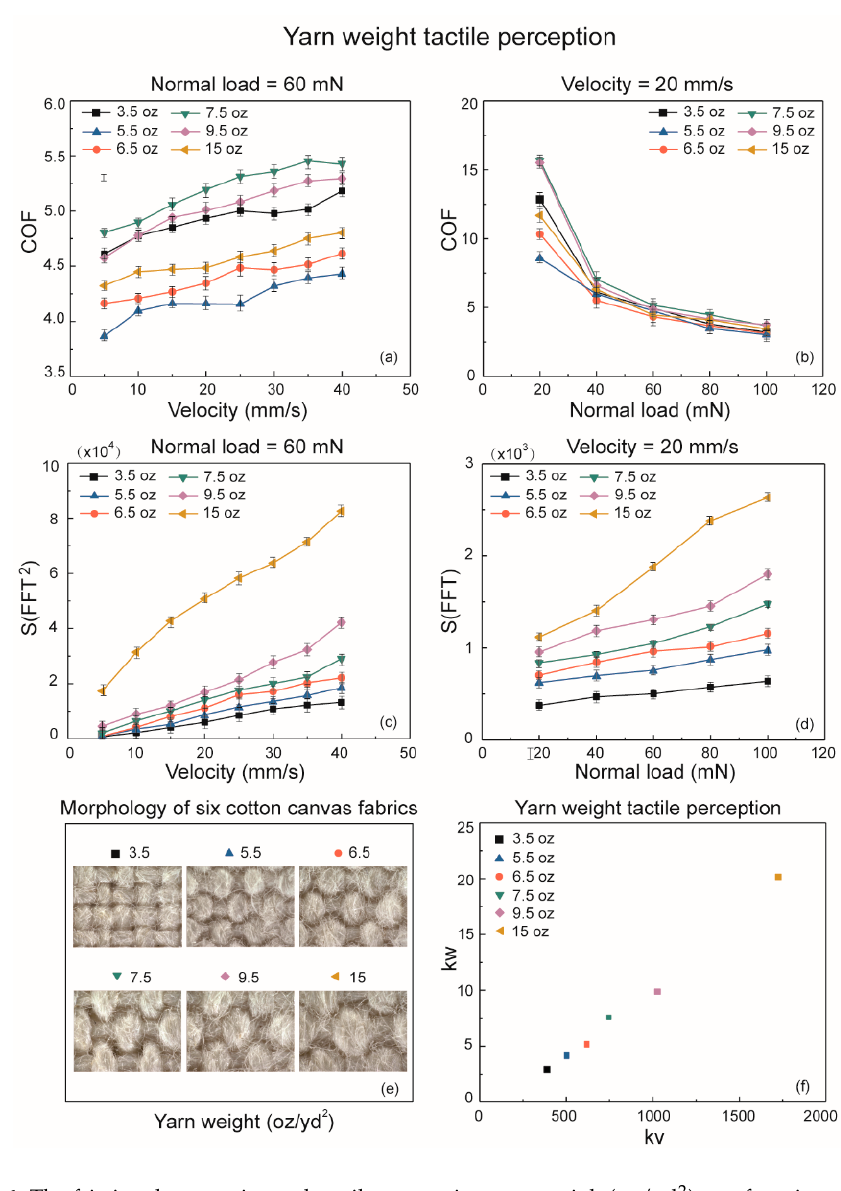
Figure 4. The frictional properties and tactile perception yarn weigh (oz/yd 2 ) as a function of velocity and normal load on cotton canvas textile fabrics. ( a ) Effect of velocity on friction coefficient at 60 mN preload. ( b ) Effect of normal load on friction coefficient at 20 mm/s scanning velocity. ( c ) Tactile perception of yarn weight by S ( FFT 2 ) at 60 mN normal load. ( d ) Tactile perception of yarn weight by S ( FFT ) at 20 mm/s scanning velocity. ( e ) Microscope photographs of six cotton canvas fabrics with different yarn weights. ( f ) Yarn weight tactile discrimination by kv and kw .